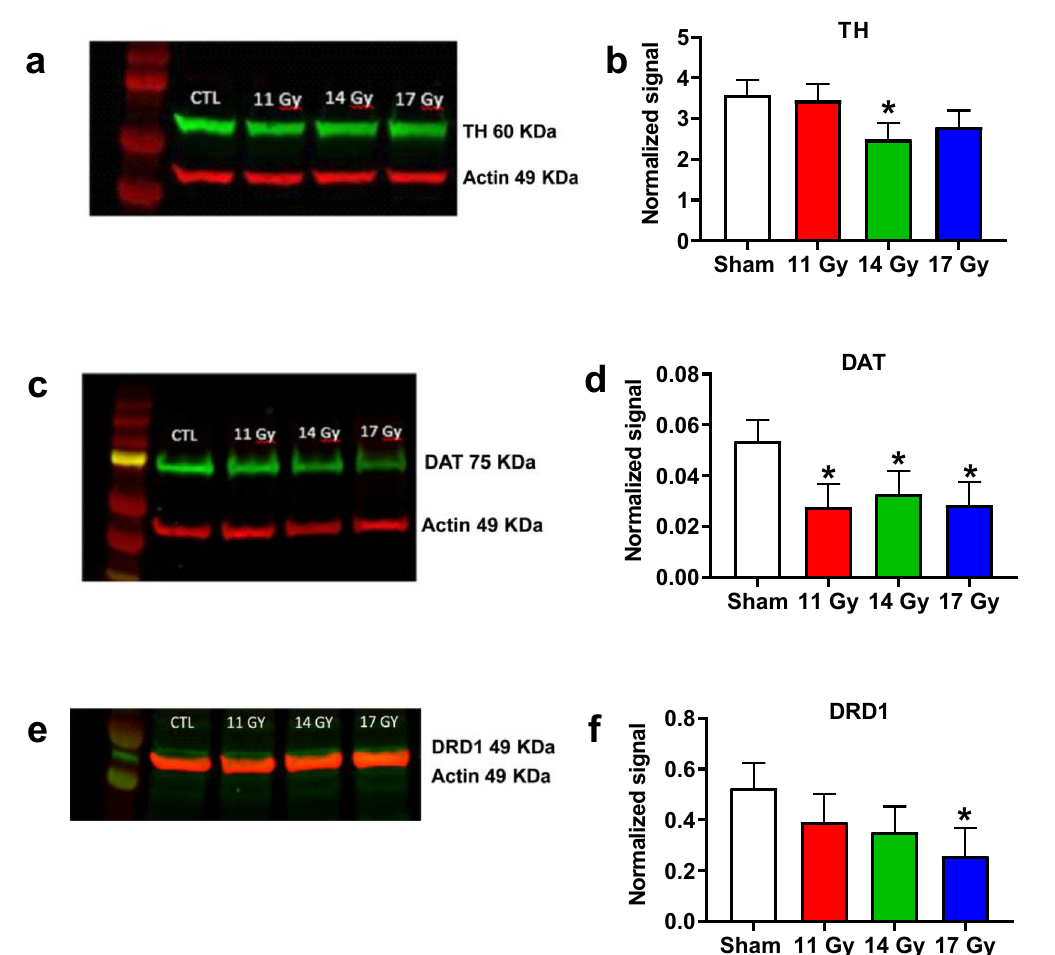
Figure 11. Western blot data for TH ( a , b ), DAT ( c , d ), and DRD1 ( e , f ) for proton irradiated and control rats. Full-length blots/gels are presented in Supplementary Materials Figure S1a–c. * p < 0.05 compared with controls. N =